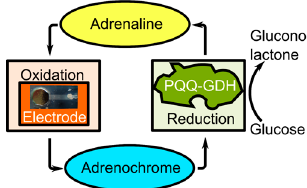
Figure 1. Scheme of bioelectrocatalytical measurement principle for amplification of the adrenaline sensor signal. In a first reaction step, adrenaline is oxidized to adrenochrome. Then, reduction of adrenochrome was catalyzed by the enzyme PQQ-GDH.